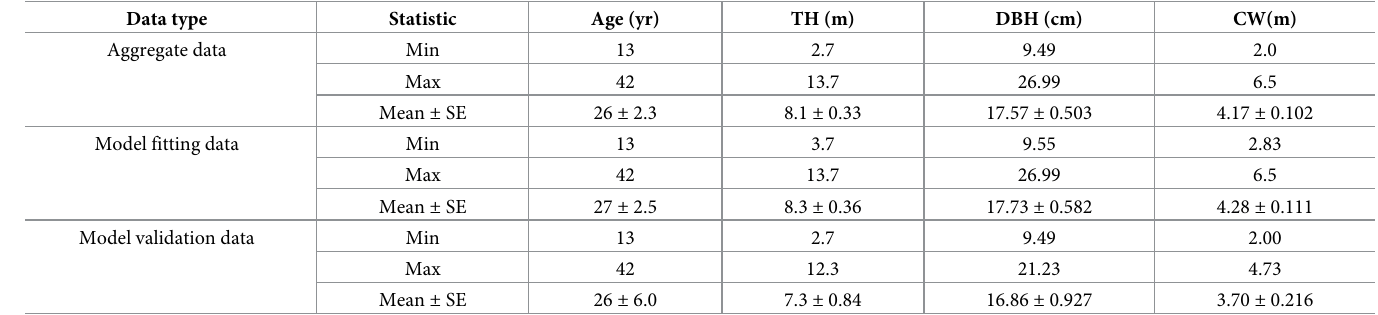
Table 1. Summary statistics of stand